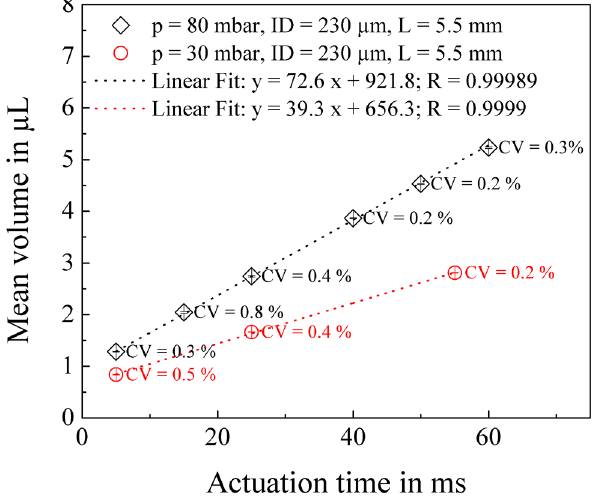
Figure 7. The dispensing performance shows a linear dependency between the actuation time and the dispensed mean volume. Each data point represents the mean volume of one run of 24 individual measurements. The percentage values state the respective